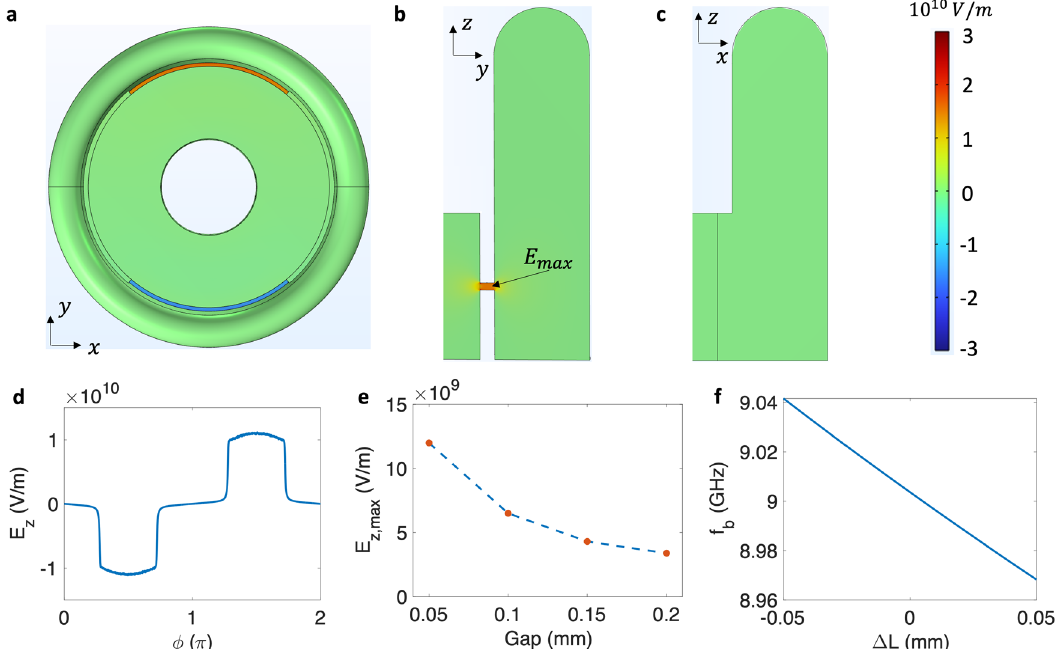
Fig. 2 Simulation of the microwave mode near 9 GHz. The simulation is based on stored energy of 1 J. a - c z-component of the electric fi eld in the SRF cavity on the ( a ) x − y plane, ( b ) y − z plane, and ( c ) x − z plane. The prism for the optical coupling is located in the wider section displayed in c . d Azimuthal distribution of the z component of the electric fi eld ( E Z ) along the rim of the LN optical resonator. e Maximum electric fi eld on the y − z plane at the rim of the LN crystal (shown in b ) versus the gap size (shown in Fig. 1 b ). f Microwave frequency tuning as a function of variations of the vacuum stub length Δ L